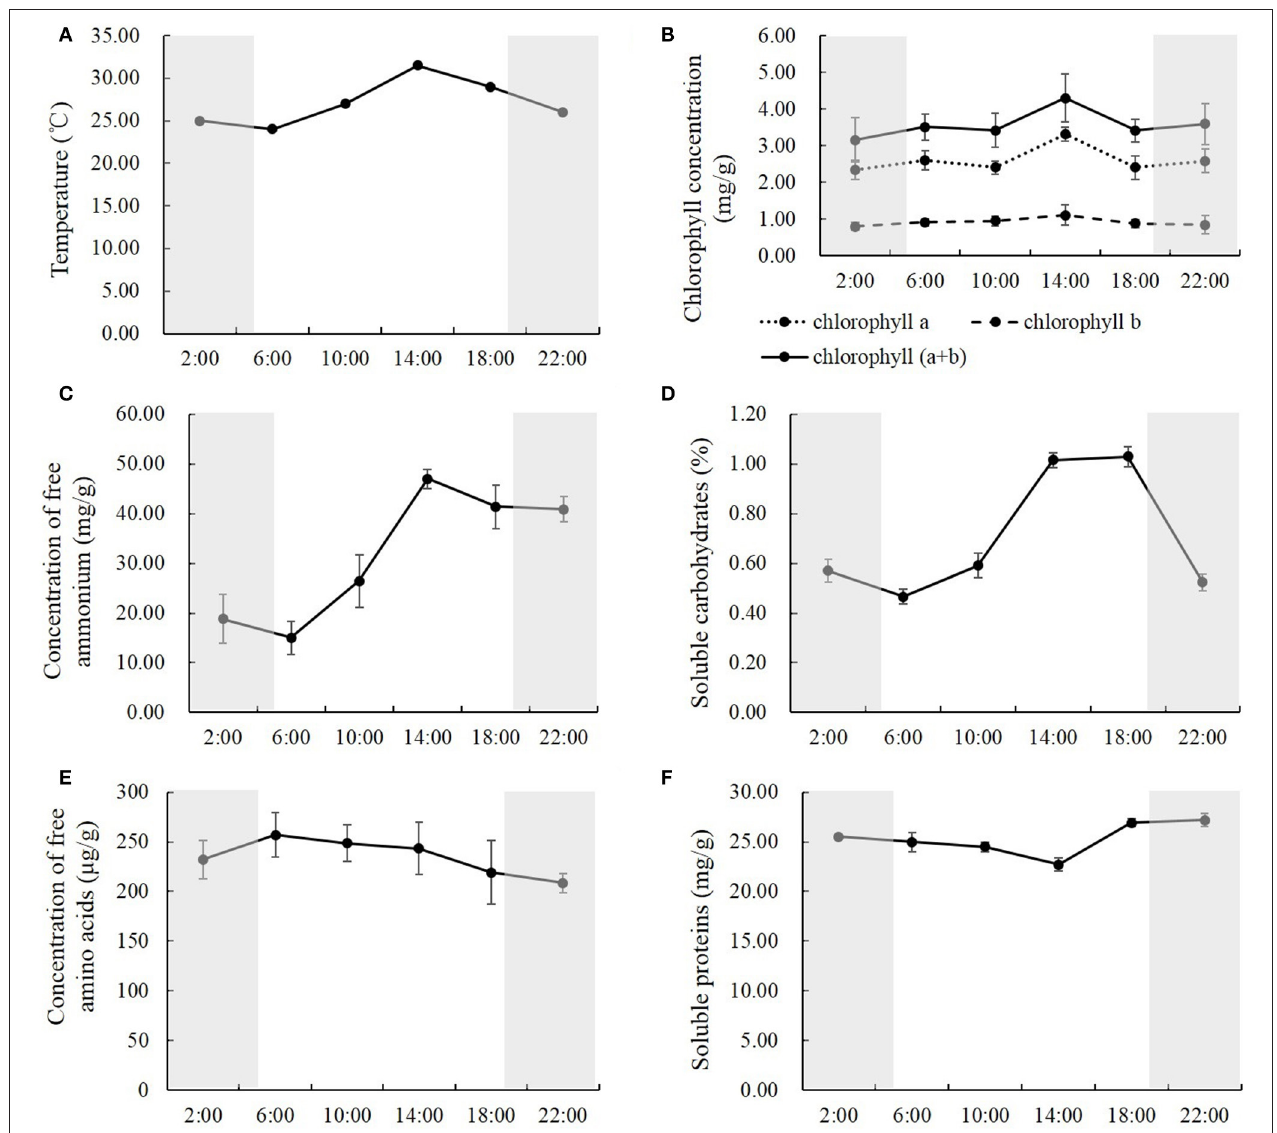
FIGURE 2 | The temperature (A), the concentrations of chlorophyll (B), free ammonium (C) and amino acids (E), soluble carbohydrates (D), and proteins (F) in the rice shoots at the time of 2:00, 6:00, 10:00, 14:00, 18:00, and 22:00. Values are mean ± SD from three biological replicates.